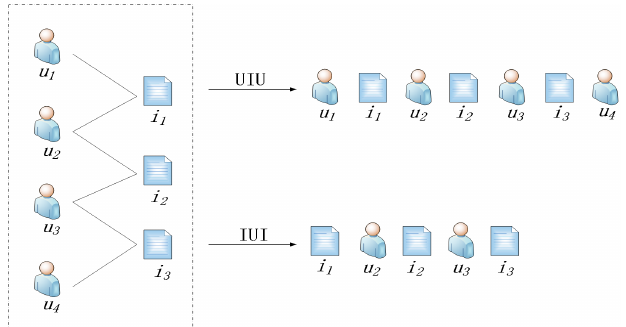
Figure 1. The selected